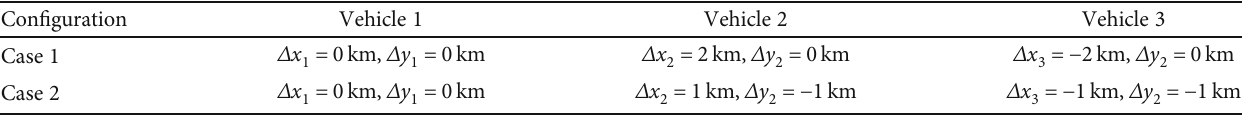
Table 2: Two di ff erent formation con fi gurations.